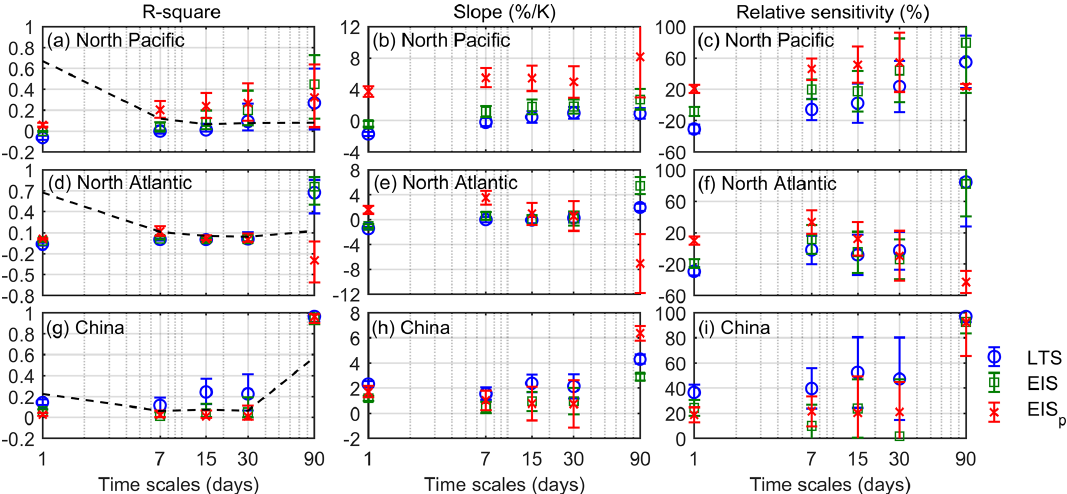
Figure 11. Similar to Fig. 10 but for the other three regions defined in Klein and Hartmann (1993), including two midlatitude oceans and one subtropical land. The minus (plus) sign of R square indicates negative (positive)